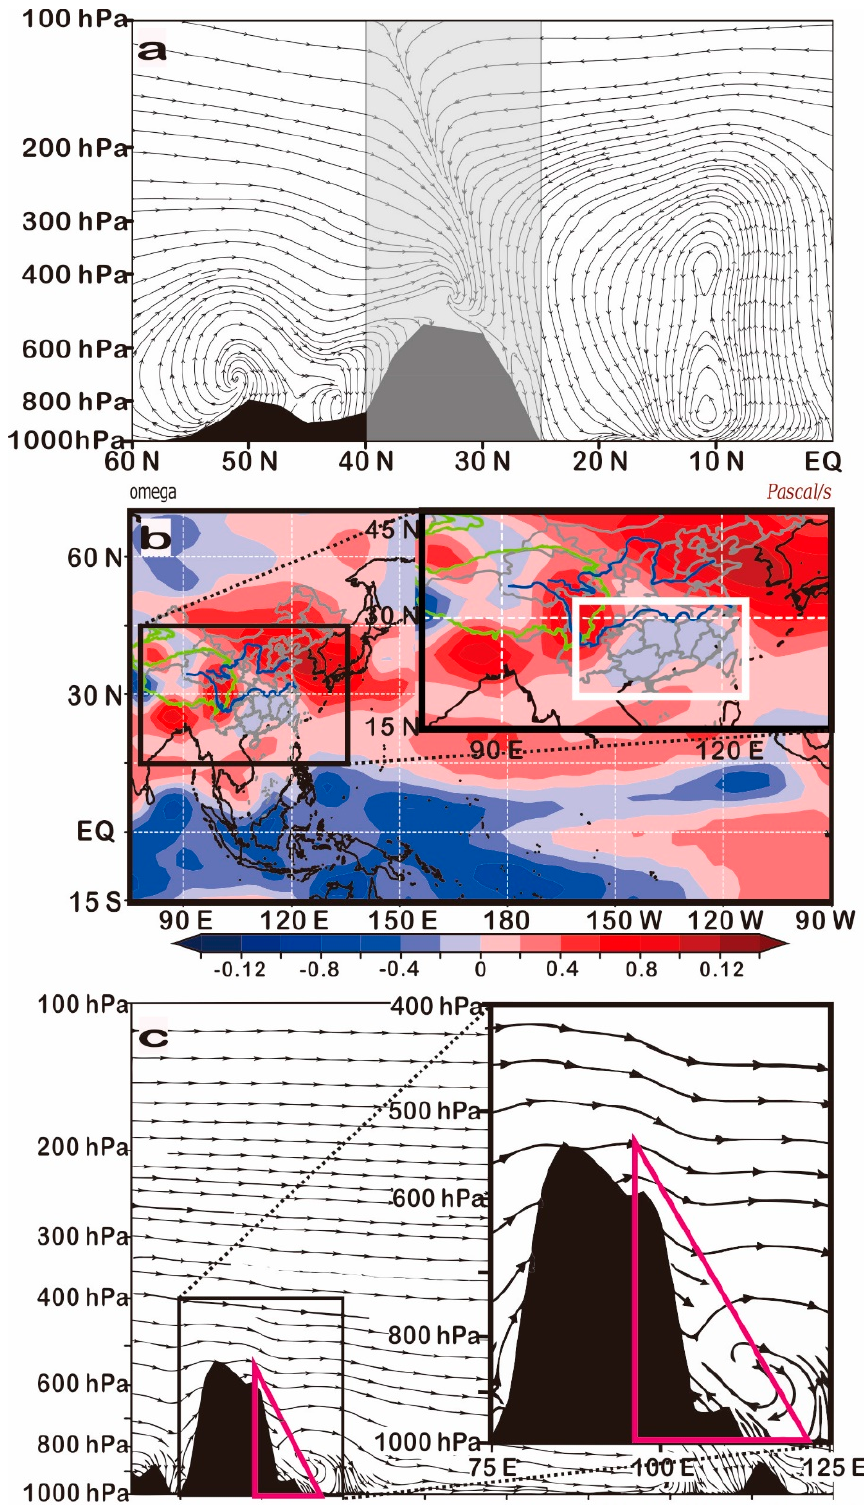
Figure 5. Wind velocity fields. ( a ) Mean meridional circulation at 90° E in January. ( b ) Vertical velocity field at 500 hPa in January. ( c ) Mean zonal circulation at 30°N in January. The grey area in part ( a ) represents the Tibetan Plateau area, and the white rectangle ( b ) represents the downdraft area and the red triangle ( c ) represents the intersection of the updraft and the downdraft.